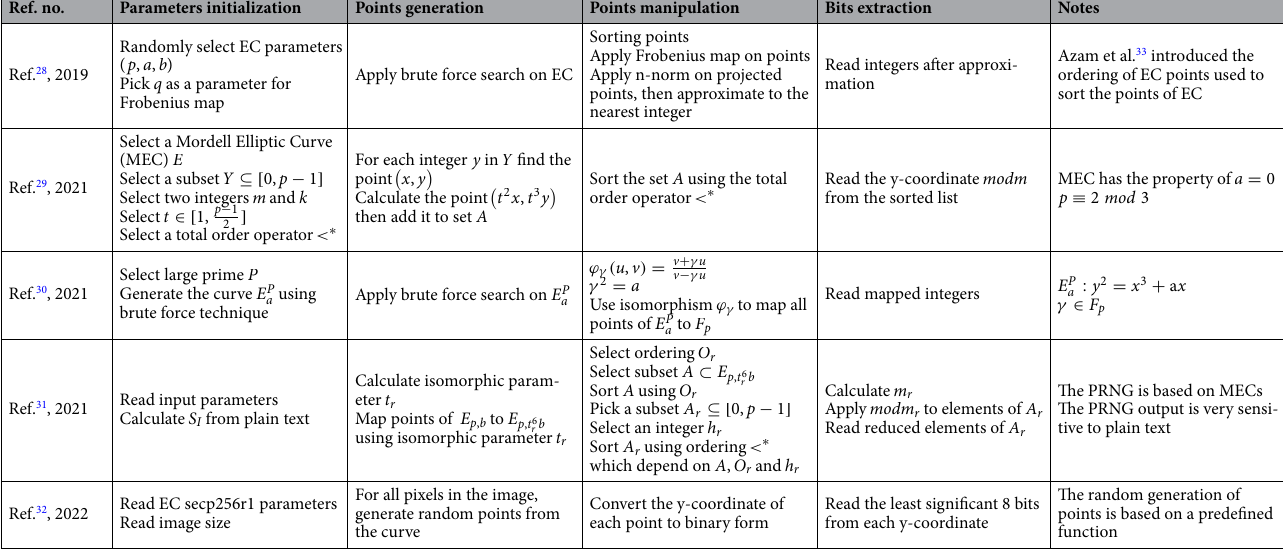
Table 3. Mapping of the surveyed non-iterative techniques into the proposed framework.